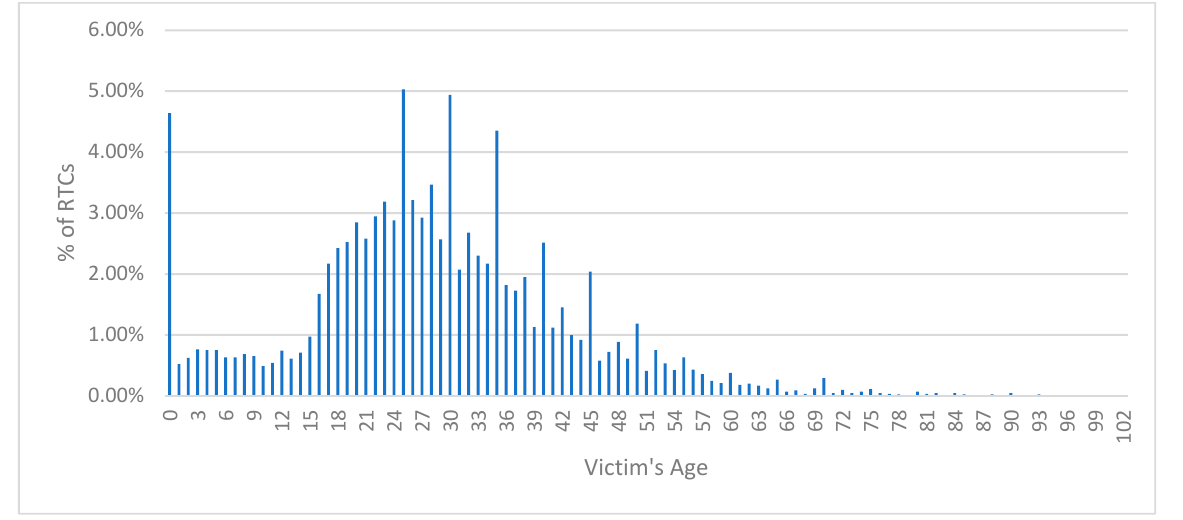
Figure 6. Age-wise distribution of RTC victims. Table 3. Descriptive statistics for RTCs, major injuries, and